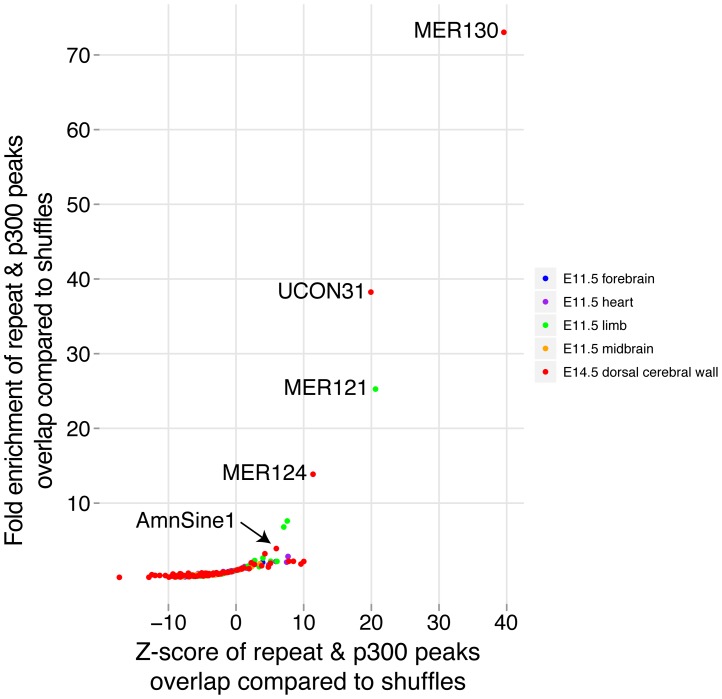
Co-option of mobile elements as dorsal cerebral wall enhancers.Each p300 ChIP-seq set was overlapped with all interspersed repeat families. For each combination, the expected number of overlaps was determined using 10,000 simulations where the p300 set was randomly distributed across the genome and overlaps were counted.